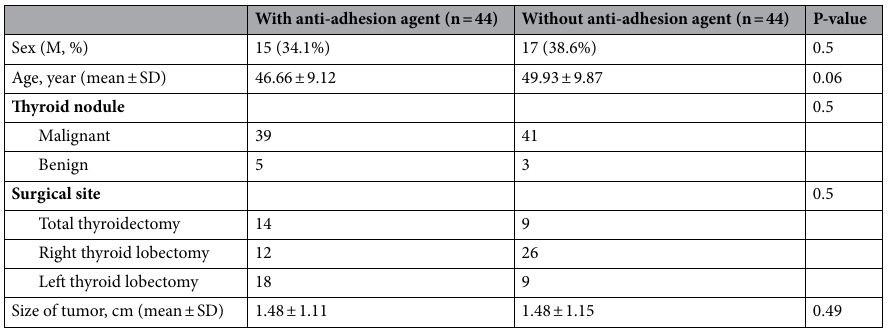
Table 1. Demographic and clinical characteristics of patients who underwent thyroidectomy with and without an anti-adhesion agent. SD standard deviation.